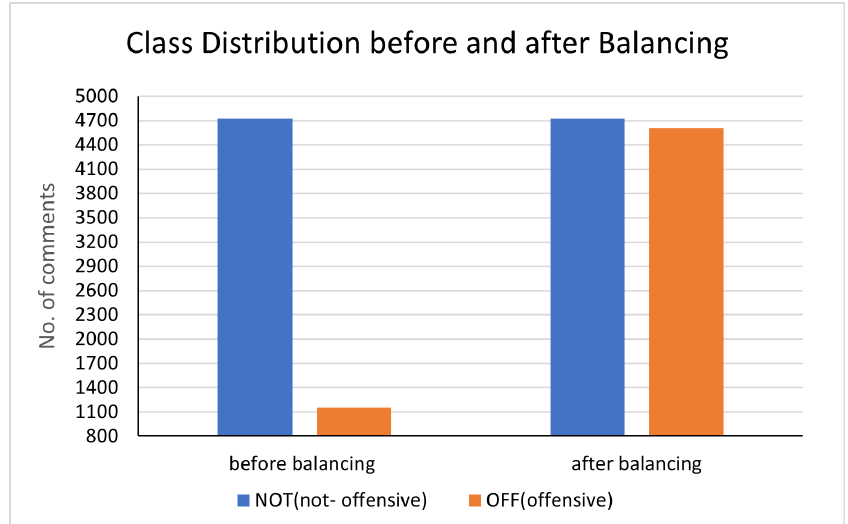
Figure 8. Class distribution before and after balancing the dataset.